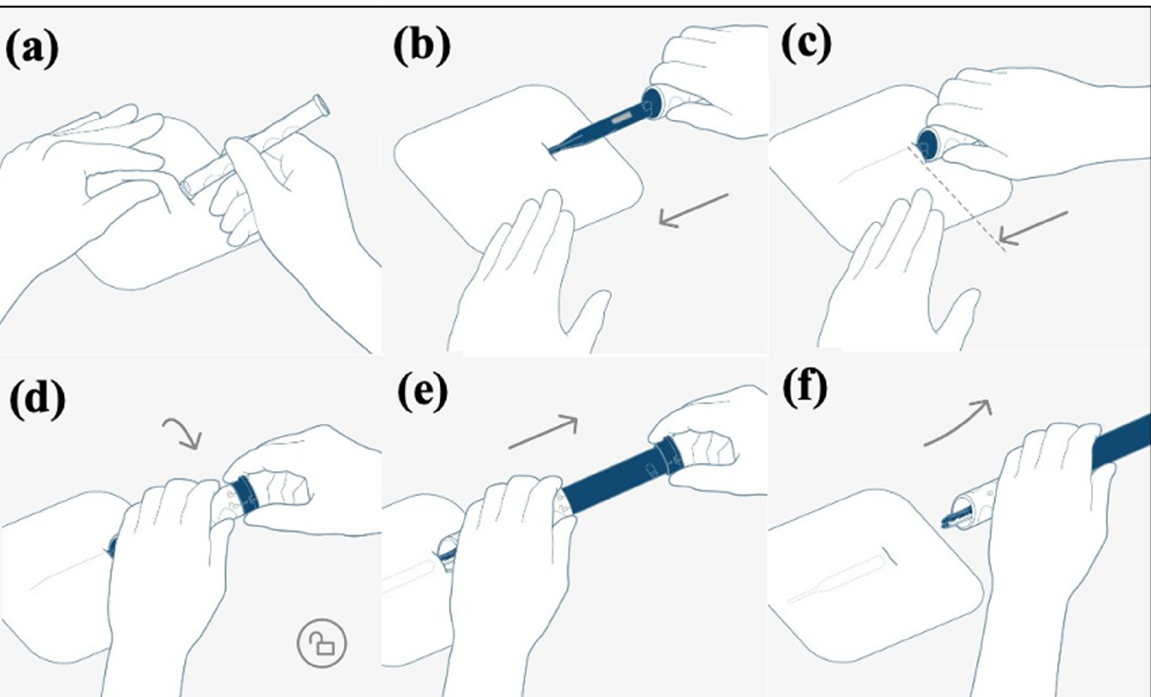
Figure 1. Insertion procedure: ( a ) A skin fold is formed and the cutting tool produces a defined incision. ( b , c ) The fast insertion tool forms the device pocket. ( d ) The tool is unlocked. ( e , f ) The tool holds the device in place while it is withdrawn from the pocket. Reprinted with permission from BIOTRONIK SE & Co., KG, Berlin, Germany.